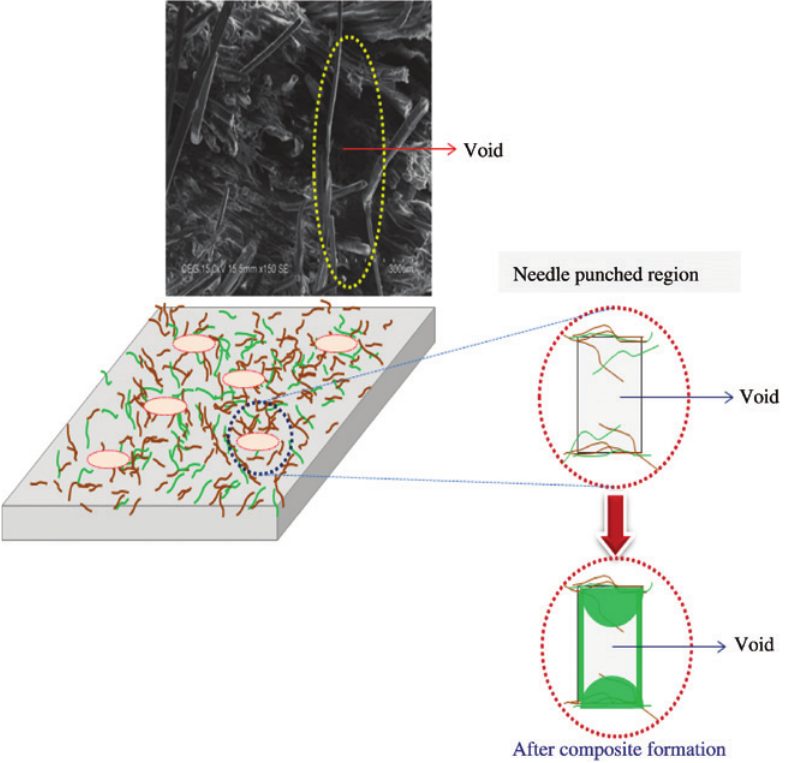
Figure 8: Schematic diagrams along with the SEM micrograph of the specimen of void formation with respect to needling density.